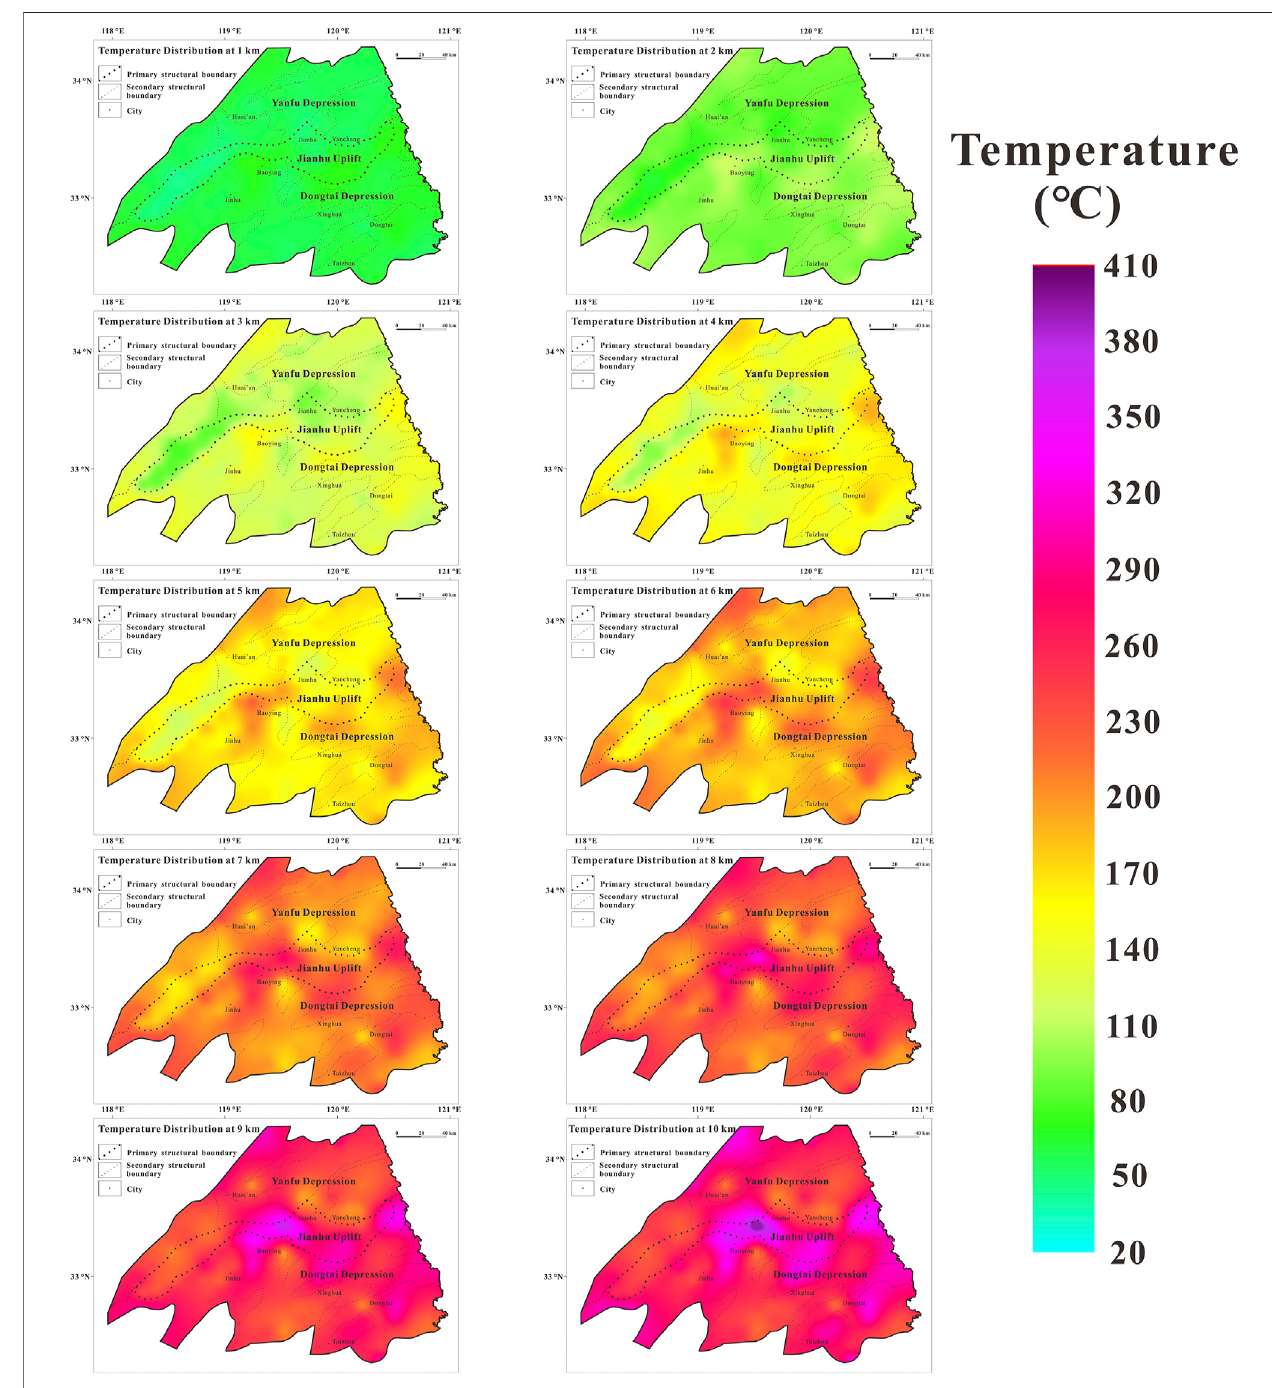
FIGURE 7 | Distribution characteristics of the geothermal fi eld at different depths of 1 – 10 km in the North Jiangsu Basin.